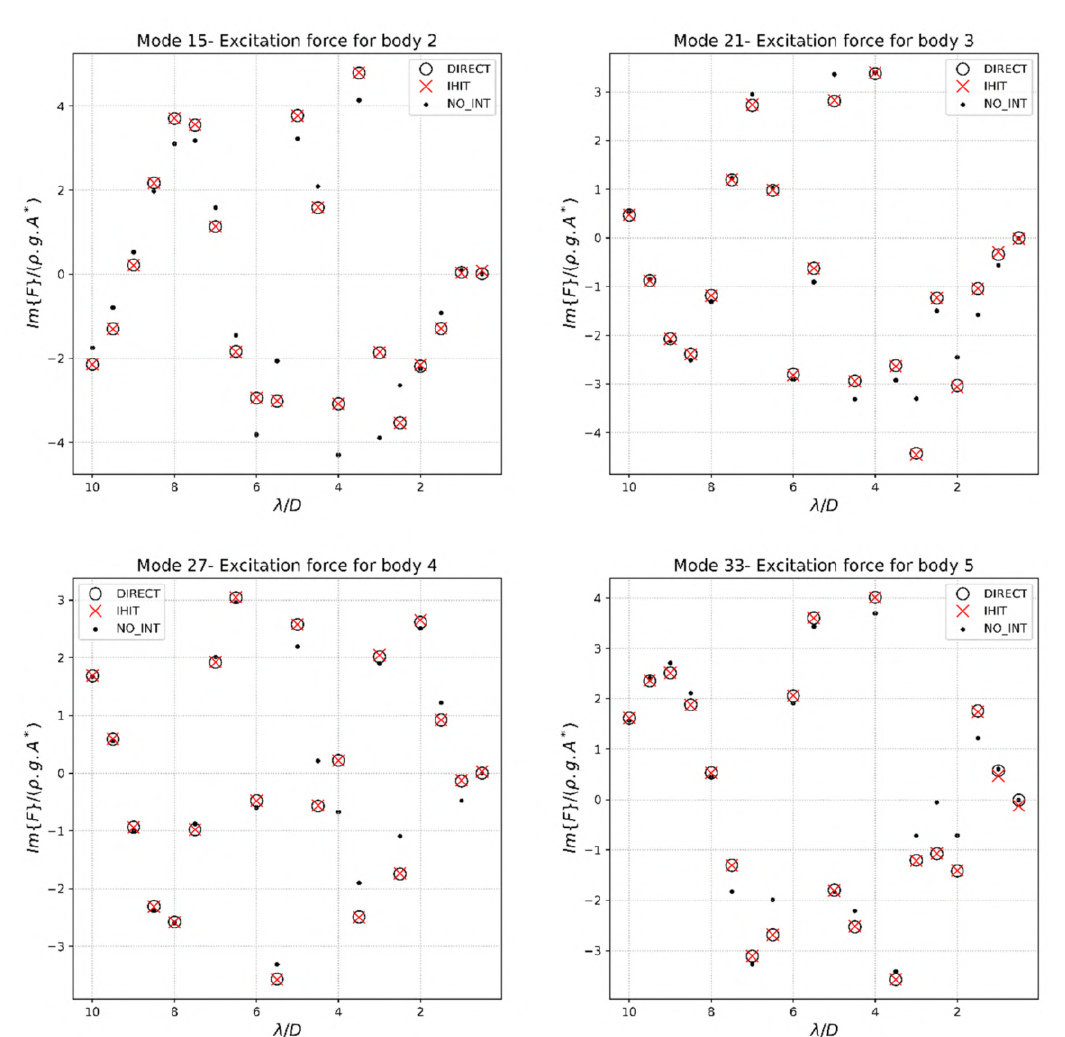
Figure 5. Imaginary part of the excitation forces in heave for each body. “DIRECT”, “IHIT”, and “NO_INT” denote the solution using WAMIT with the direct method, the solution using the interaction theory with inhomogeneous wave field, and the solution for a single isolated body using the direct method and body W 1 , respectively. F , ρ , g , and A* , stand for the excitation force, the fluid density, the standard gravity acceleration, and the heave amplitude of body W 1 , respectively.